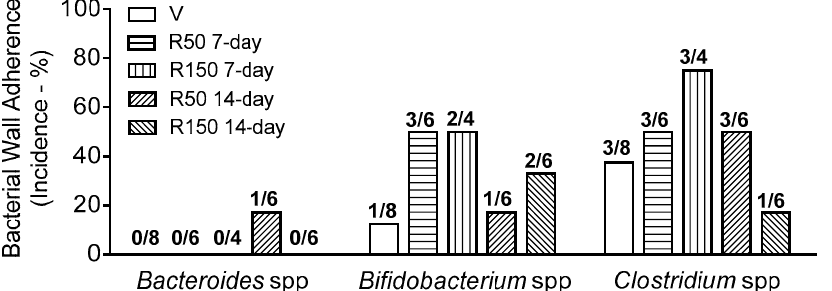
Figure 6. Incidence of bacterial wall adherence. Data represent the percentage of animals showing bacterial wall adherence. Numbers on top of columns represent the number of animals showing bacterial wall adherence over the total number of animals. For the sake of clarity, and since differences were not observed among them, vehicle-treated animals have been merged in a single group ( n = 8). V: Vehicle; R50: rifaximin at 50 mg/kg; R150: rifaximin at 150 mg/kg. Because of technical problems, one of the samples from group R150 7-day was lost during its processing.